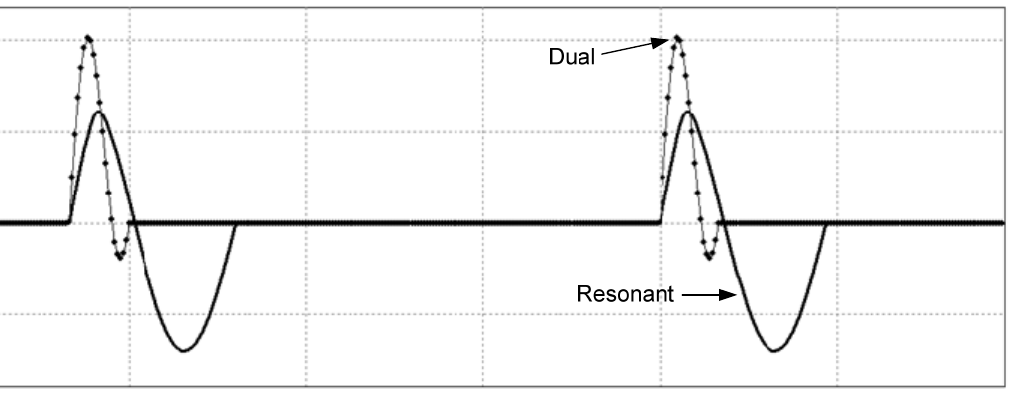
= 100 V, output voltage V = 400 V, output power in o = 100 kHz. Scale: I = 20A/div., Time: t = 5 μ sw